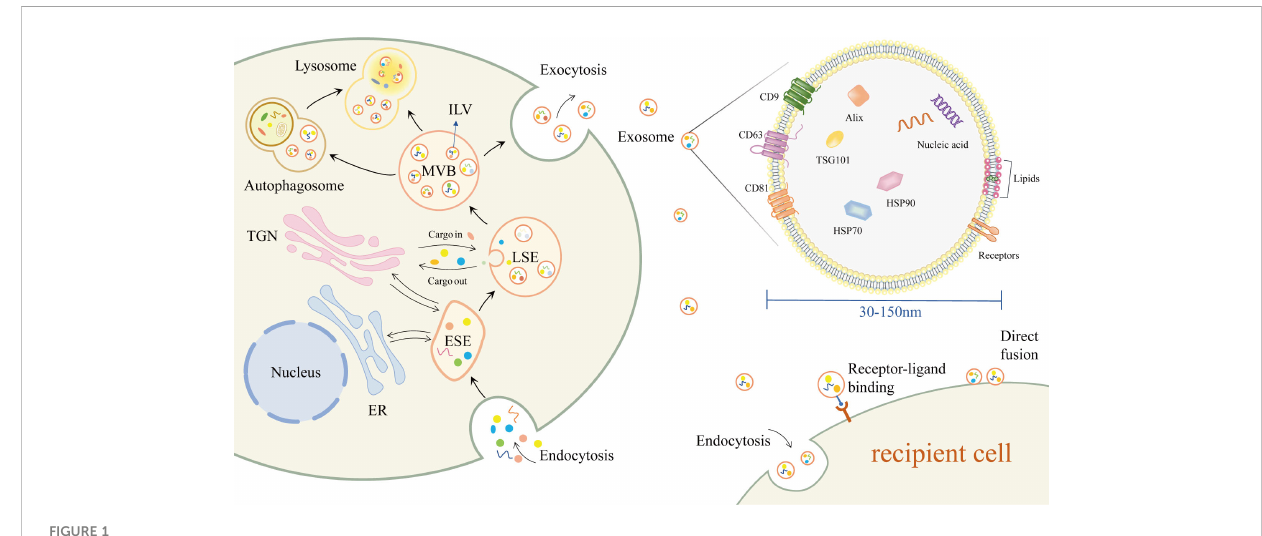
FIGURE 1 Biogenesis, composition, secretion and uptake of